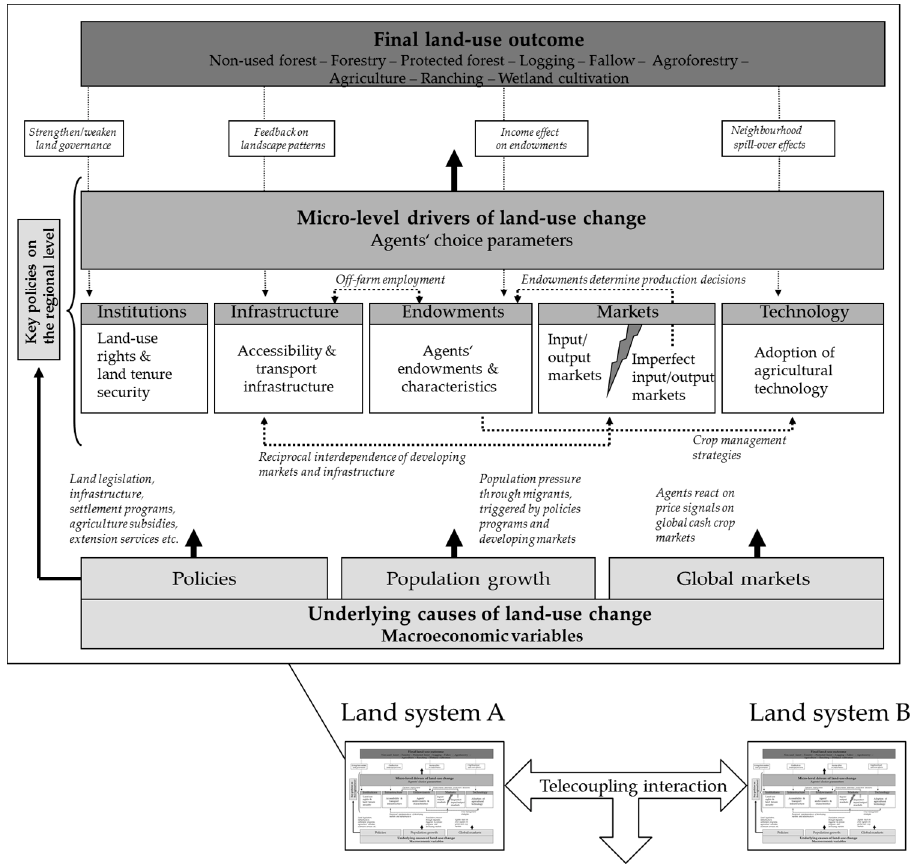
Figure 1. Concept of the micro-level drivers of land-use change. Authors’ concept based on Angelsen and Kaimowitz [9], Eakin et al. [3] and Liu et al. [2].